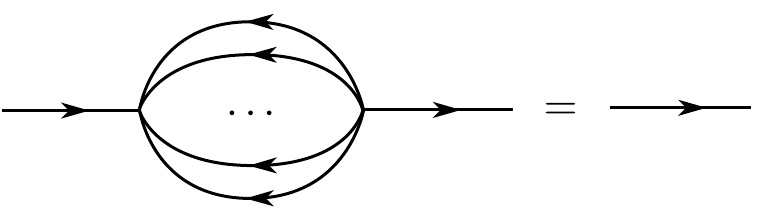
Figure 1 . Schwinger-Dyson equation for the two-point function. The melonic part contains an even number of